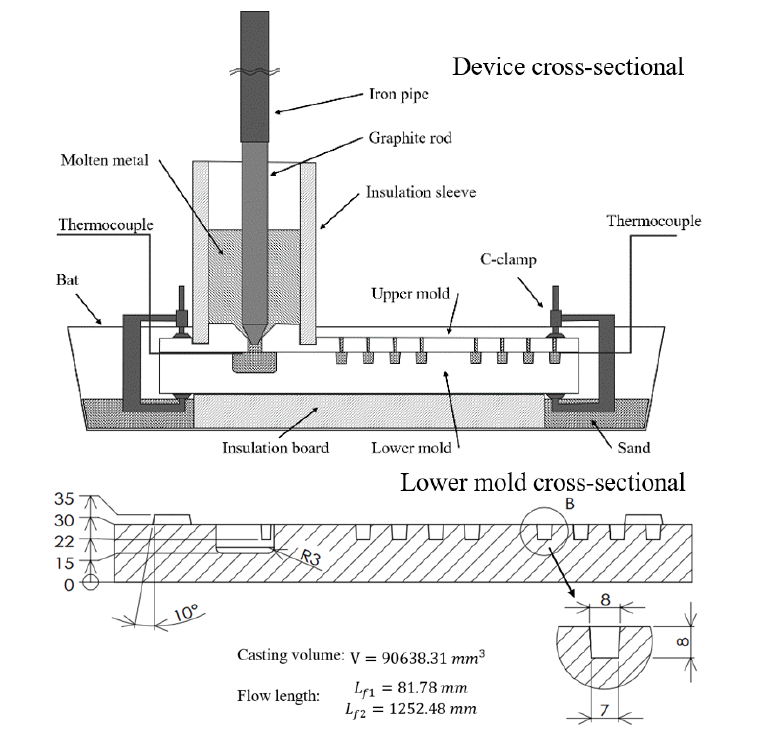
Figure 5. Schematic diagram of spiral flow test (cross-section)